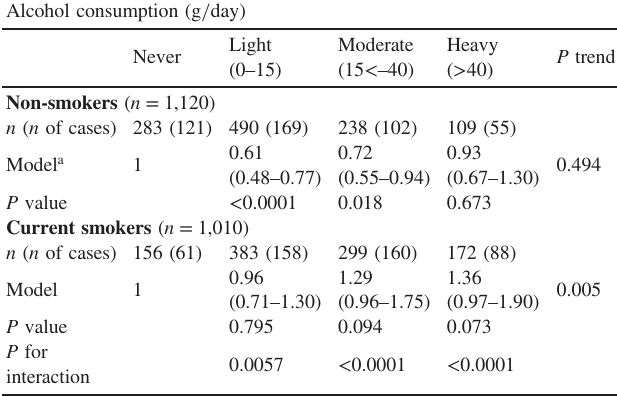
Table 4. Hazard ratios and 95% con fi dence intervals for risk of incident hypertriglyceridemia according to alcohol consumption strati fi ed by smoking status in Korean